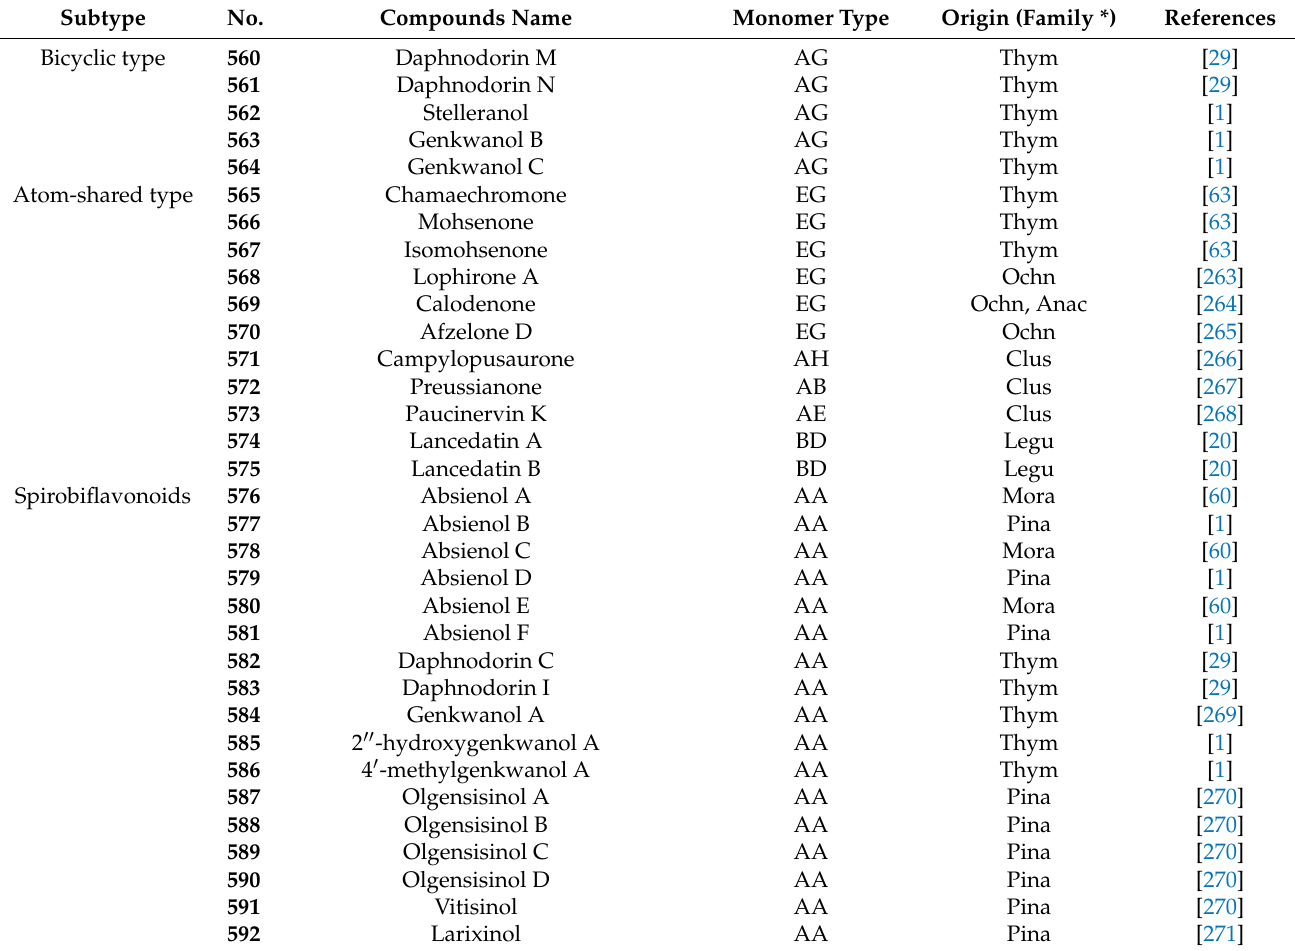
Table 11. The other types of